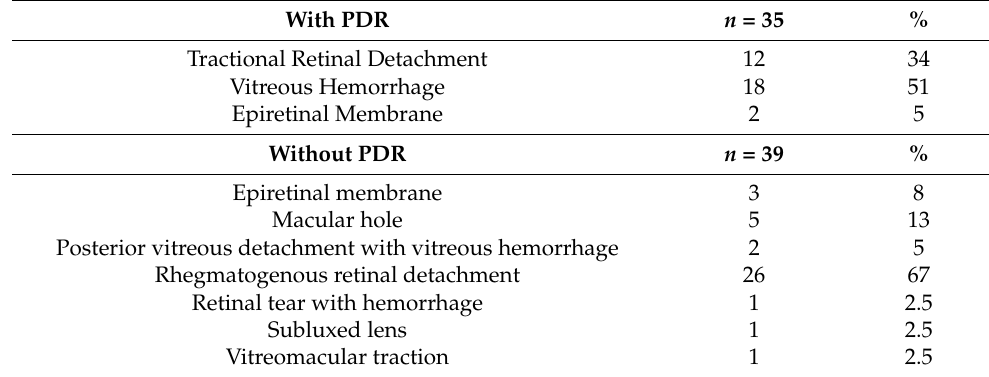
Table 1. Indications for surgery among patients with and without proliferative diabetic retinopathy. With PDR n = 35 % Tractional Retinal Detachment 12 34 Vitreous Hemorrhage 18 51 Epiretinal Membrane 2 5 Without PDR n = 39 % Epiretinal membrane 3 Macular hole Posterior vitreous detachment with vitreous hemorrhage Rhegmatogenous retinal